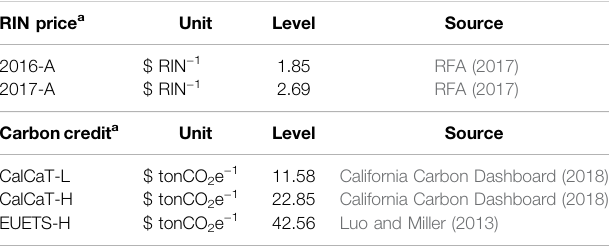
TABLE 3 | RIN credits and parameters for carbon credit